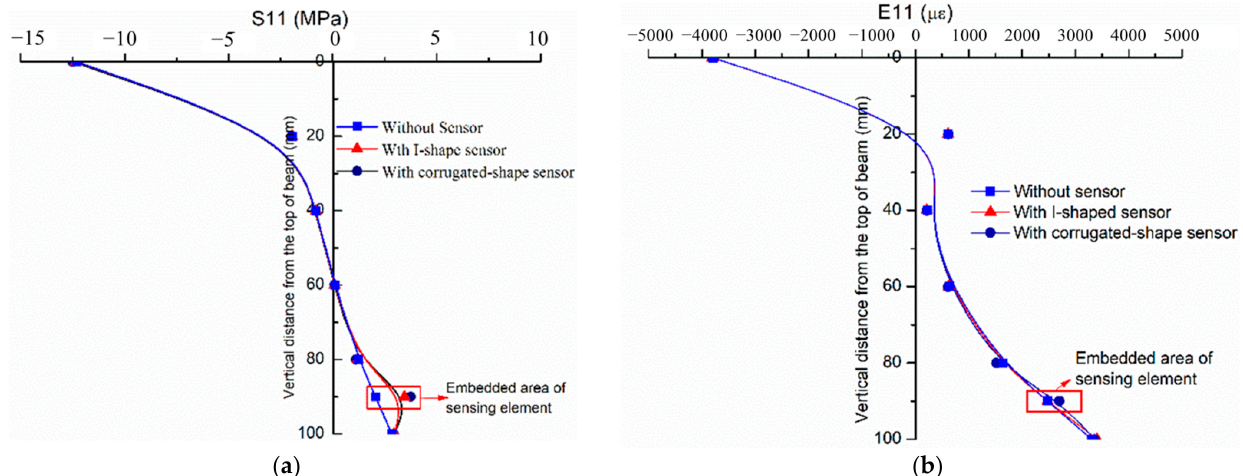
Figure 5. Change in S11 and E11 with the vertical distance from the top of beam, ( a ) S11, ( b ) E11.